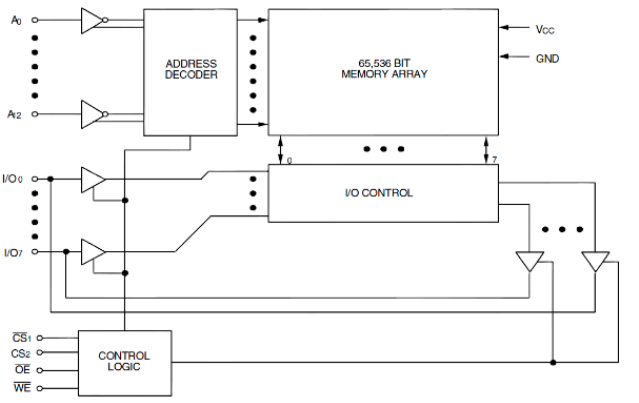
Figure 1. Schematic block diagram of